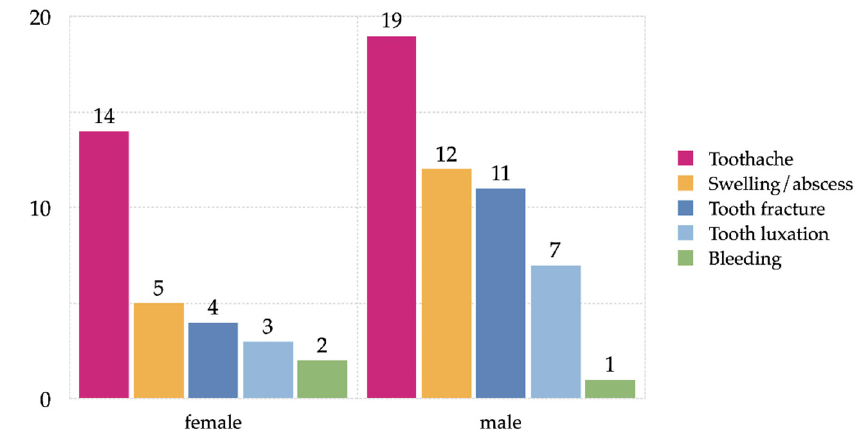
Figure 3. Overall summary of dental conditions by gender ( n = 53).